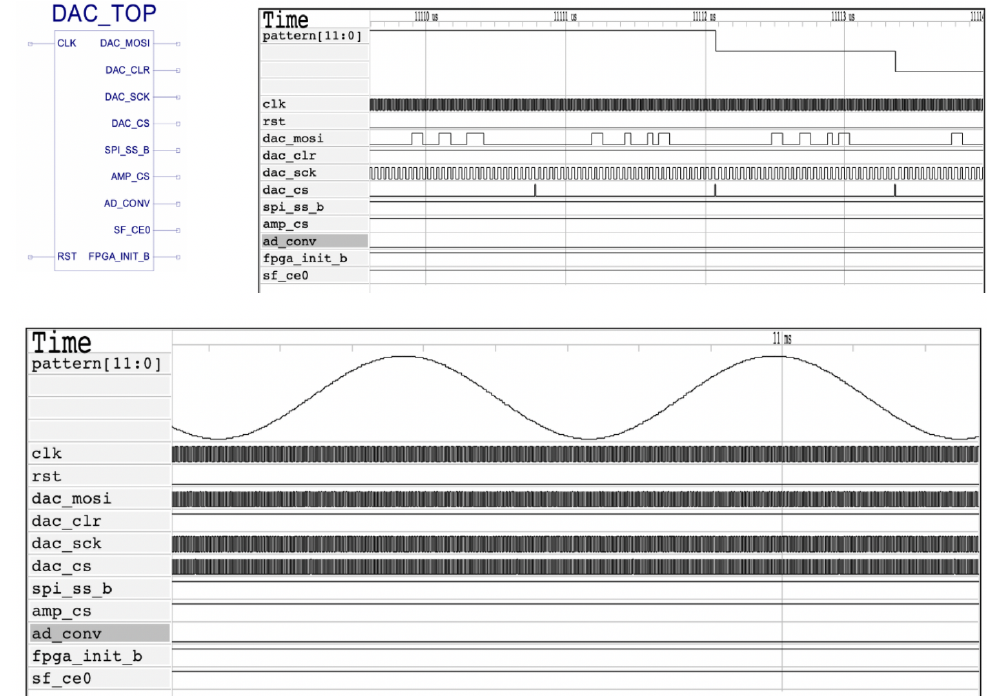
Figure 9. The DAC_TOP (designed sinusoidal waveform generator) along with its simulation results in different time intervals. The control signals are: dac _ mosi —sends commands and data to the DAC, dac _ clr —resets the DAC, dac _ sck —SPI clock to the DAC, dac _ cs —selects the SPI device to communicate with in this case, it is the DAC.